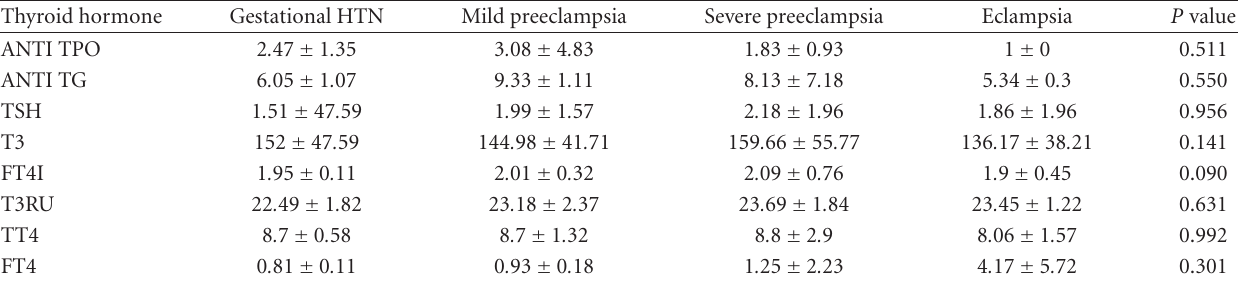
Table 3: Thyroid hormone levels in women with gestational hypertension, mild-severe preeclampsia, and eclampsia. Thyroid